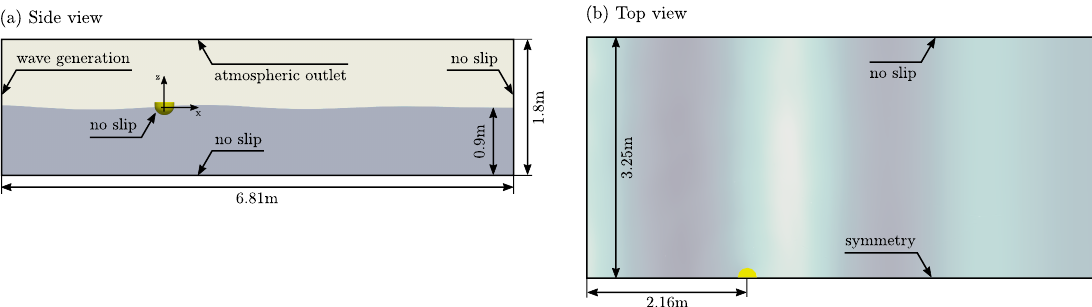
Figure 3. Schematic of the numerical wave tank: Side view ( a ) and top view ( b ).